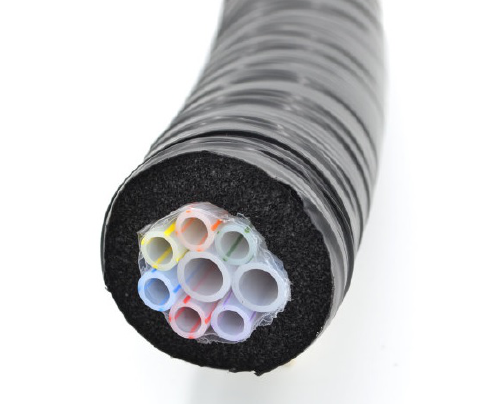
Figure 4. Python tubing with six beverage lines and a return central